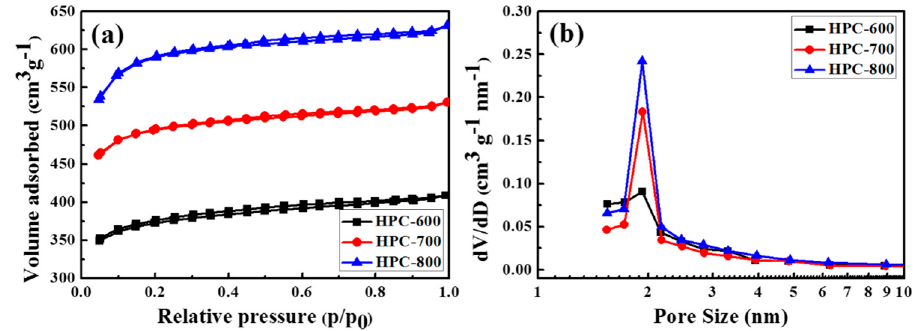
Figure 4. N 2 adsorption isotherms ( a ) and Barrett–Joyner–Halenda (BJH) pore size distributions ( b ) for the HPCs.